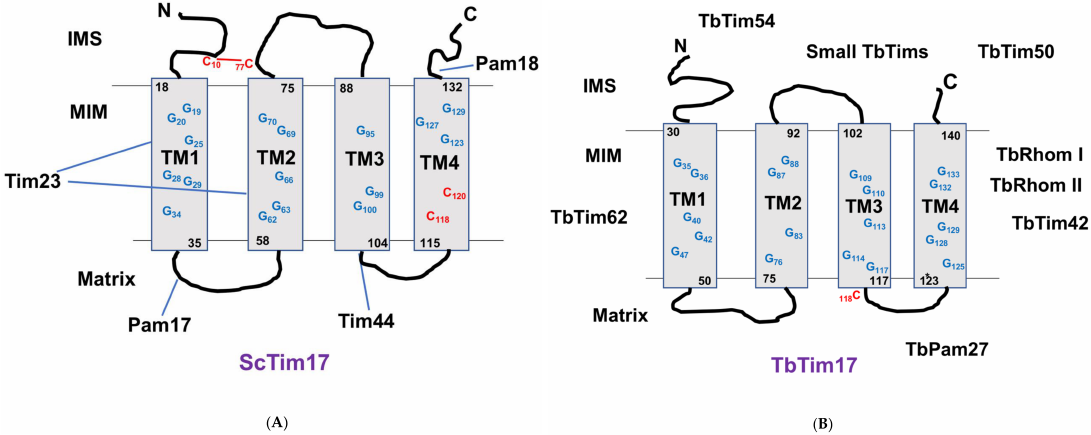
Figure 2. Schematics of the secondary structures of Tim17 of the Saccharomyces cerevisiae ( A ) and Trypanosoma brucei ( B ). Four transmembrane domains (TM1–TM4) and the hydrophilic loop